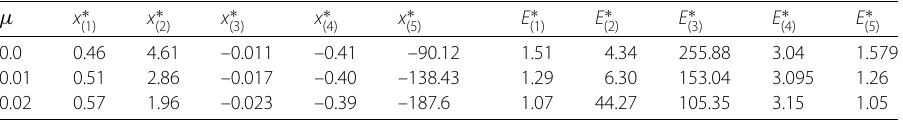
Table 2 Optimal singular solution for different discount rate μ